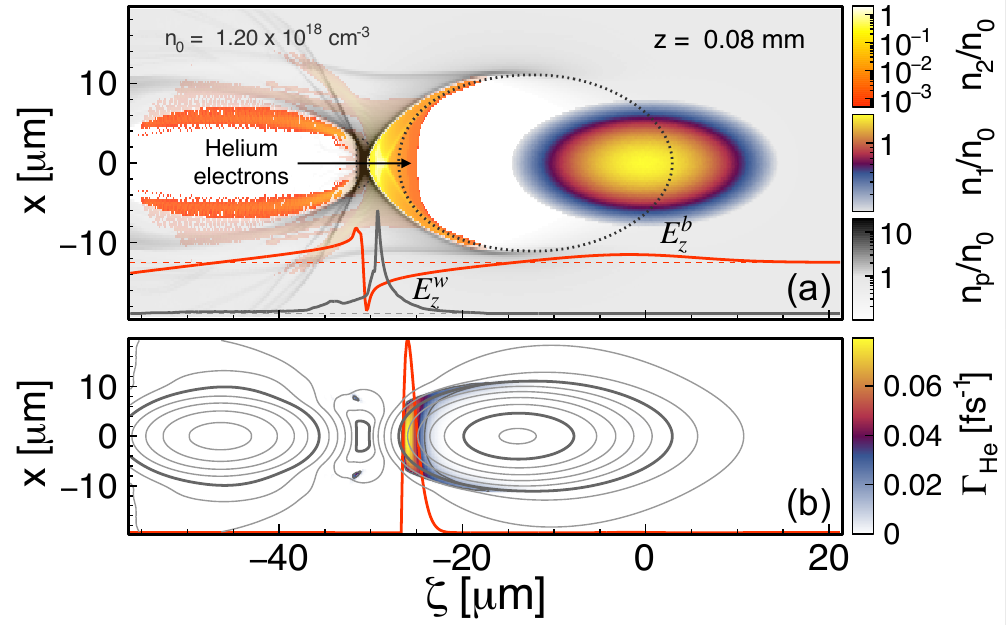
Figure 12. OSIRIS 3D simulation of a PWFA with WII injection: ( a ) electron density of the drive beam, the plasma and the ionized helium; and ( b ) ionization rate for He according to the ADK model. The contours in ( b ) show the wakefield-equipotential surfaces in steps of